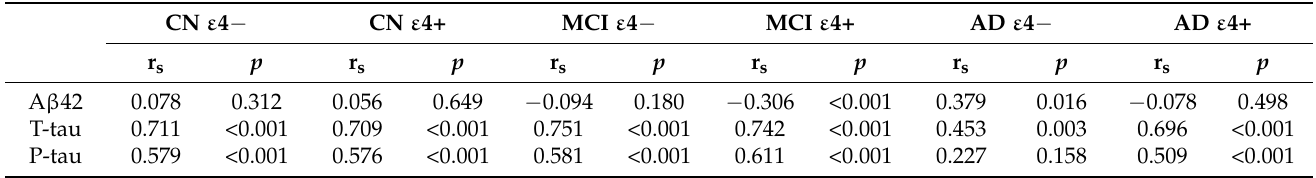
Table 2. Correlations of CSF GAP-43 levels with CSF core AD